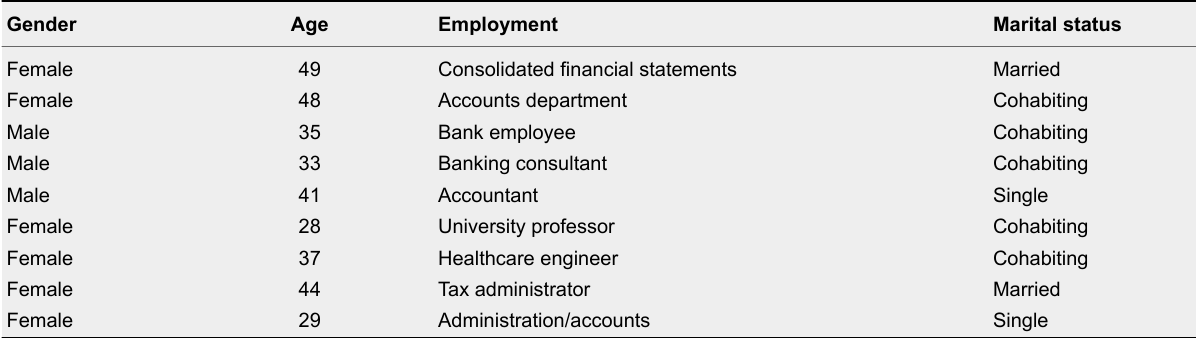
Demographic Characteristics of Participants From the Rural Environment Gender